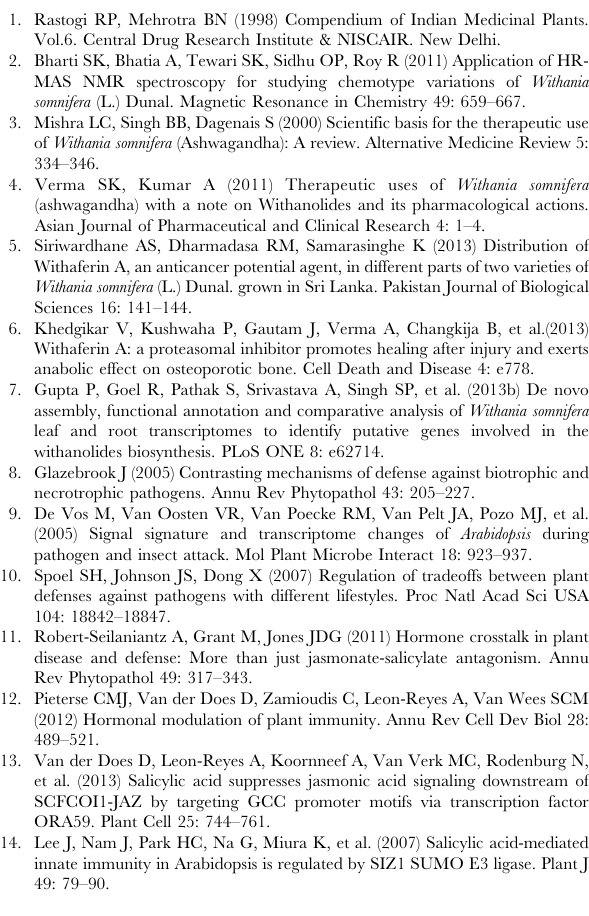
Figure S9 Melt curve analysis of PR genes used for expression profiling. Table S1 Annotation of W. somnifera leaf transcriptome using Nr database. Table S2 Classification of transcript contigs to biological pathways in W. somnifera using KEGG database. Table S3 Comparison of number of transcript contigs repre- sented under different secondary metabolite pathways in two independent studies conducted on W. somnifera